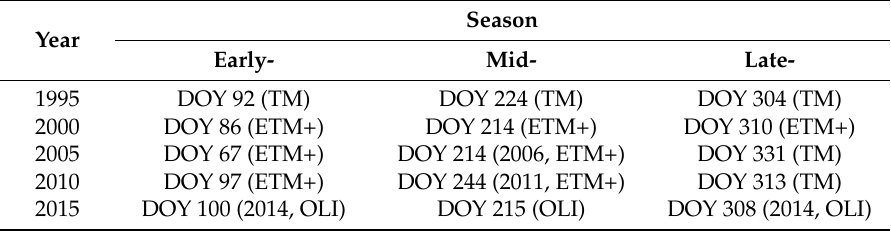
Table 2. Multi-season images used for LCLU classification with the AASG algorithm. The images for the year 1995 were classified separately and its LCLU map was used as reference map for